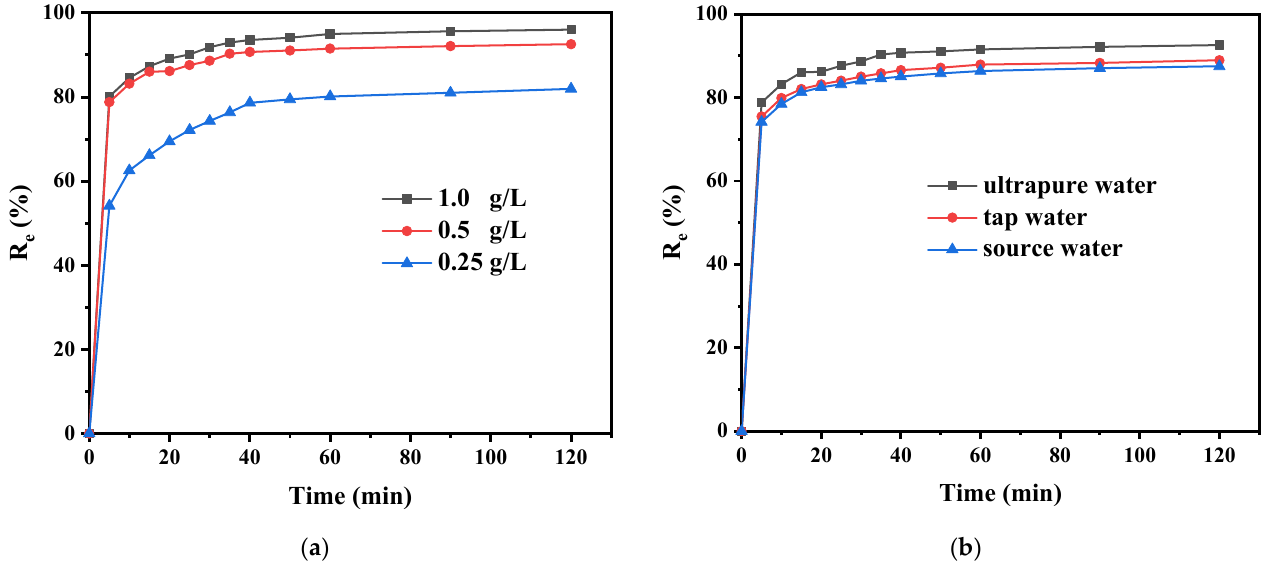
Figure 9. ( a ) The effect of MMIPs dosage on the removal efficiency for E2. ( b ) Removal efficiency of E2 by MMIPs in different water bodies. Conditions: [E2] 0 = 5 mg/L, [MMIPs or MNIPs] 0 = 0.5 g/L, T = 30 °C, and pH = 6.0.